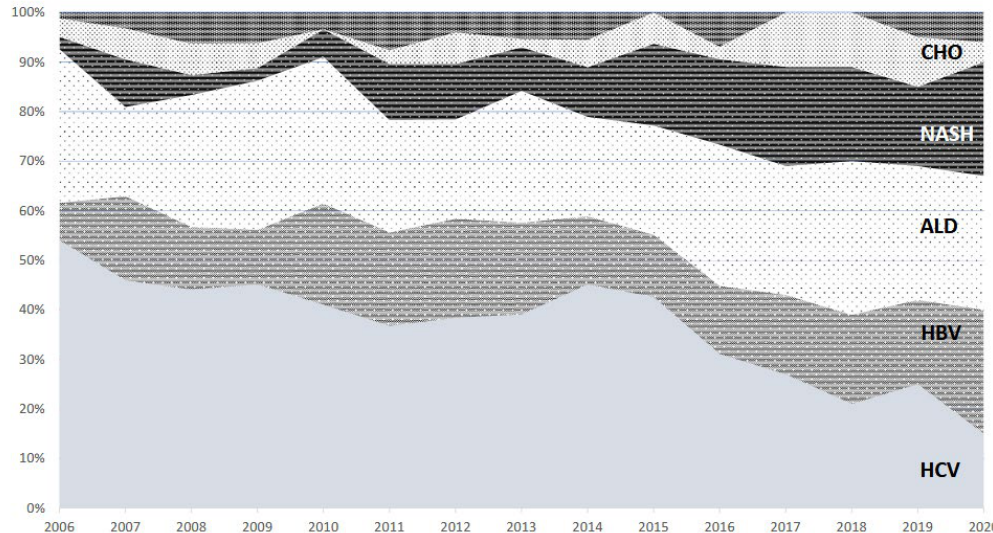
Figure 1. Temporal trends in waiting list registrations at Padua University Hospital Liver Transplant Center between 2006 and 06.2020. The field with a vertical b/w line accounts for other indications. Abbreviations. ALD: alcoholic liver disease; CHO: cholestatic/autoimmune disease; HBV: hepatitis B virus; HCV: hepatitis C virus, NASH: non-alcoholic steatohepatitis.